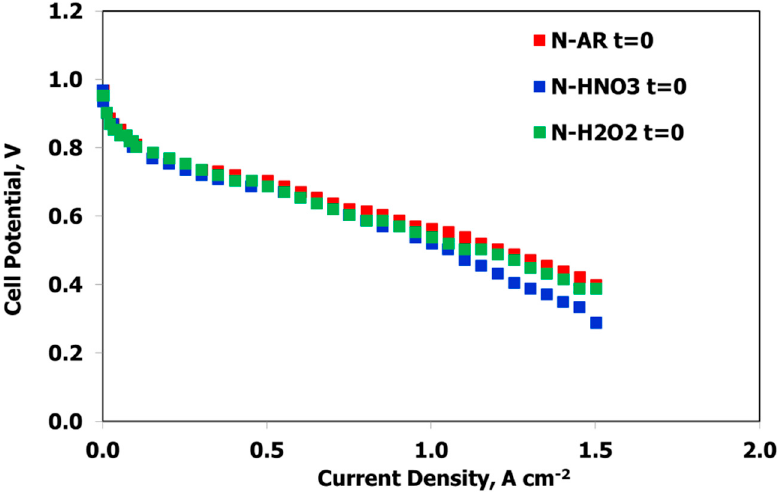
Figure 8. I–V curves at BoT (t = 0) at 80 °C, 100% RH, 1.5 abs bar. for N-AR (red squares), N-HNO3 (blue squares), N-H2O2 (green squares).